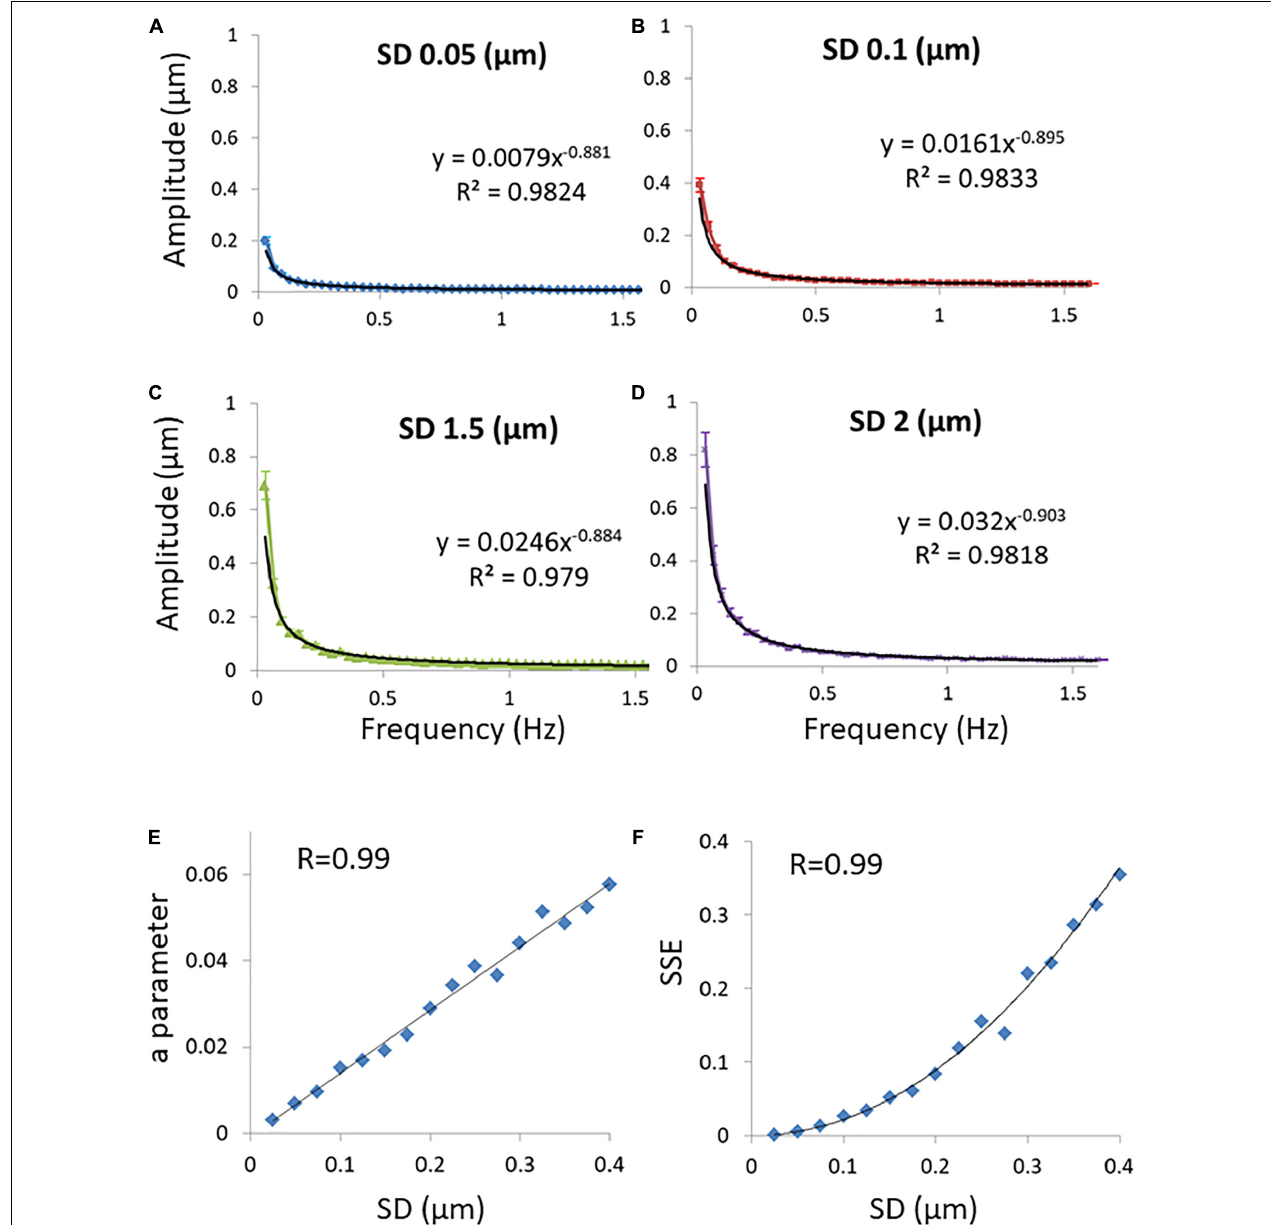
FIGURE 2 | Simulations results. (A) Discrete Fourier Transform (DFT) of a simulated particle position change in time when the probability density function’s (PDF) of translocations are Gaussian and the SD of translocations is 0.05 µ m. Power fit parameters of the DFT results are added. (B) The same as (A) except that the SD of translocations is 0.1 µ m. (C) The same as (A) except that the SD of translocations is 0.15 µ m. (D) The same as (A) except that the SD of translocations is 0.2 µ m. 50 simulations were performed for each condition described in panels (A–D) . (E) The correlation between the SD of translocations and the a parameter of the power fit results ( y = ax b ) in each condition of SD. (F) The correlation between the SD’s of translocations and the sum of squared errors (SSE) of the power fit in each condition of SD. Error bars in panels (A–D) are